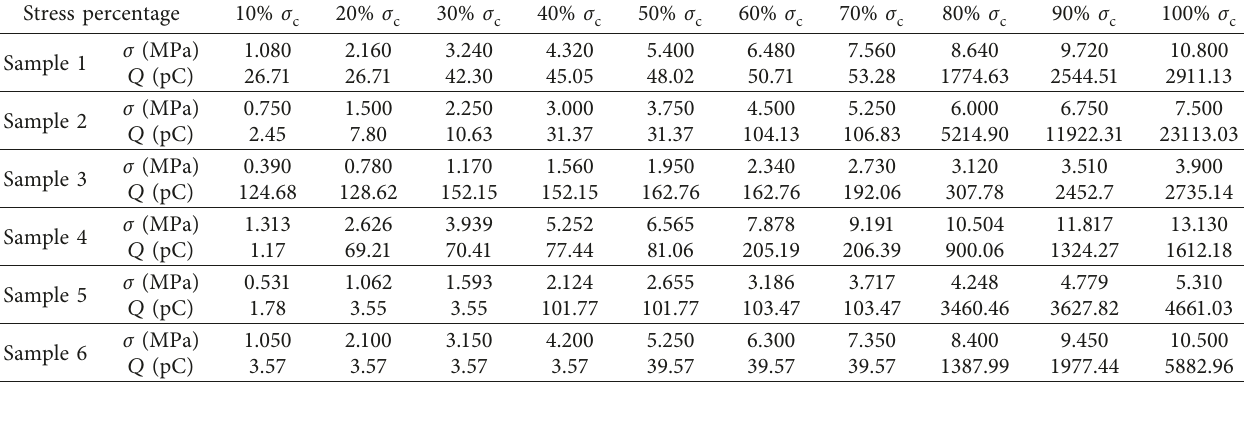
Table 1: Statistical results of prepeak stress and cumulative charge of coal